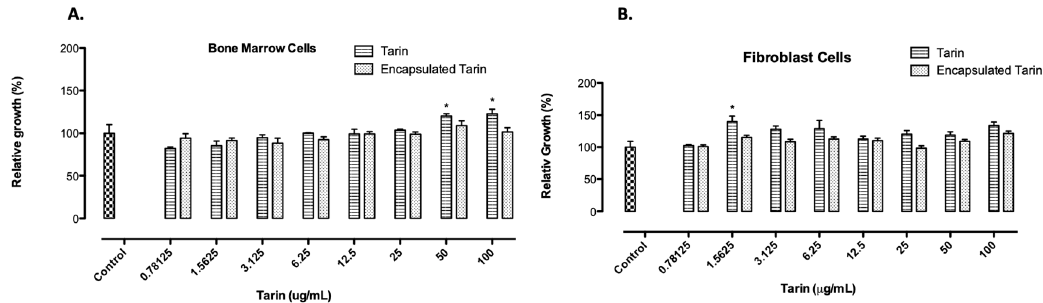
Figure 4. Toxicological effects of free or encapsulated tarin on healthy mice cells. ( A ) bone marrow and ( B ) fibroblast L929 cell line. Viability of cells exposed to increasing doses of free or encapsulated tarin for 24 h was determined using resazurin as indicator. Cultures with no tarin addition were used as control. * p < 0.05 compared to control.